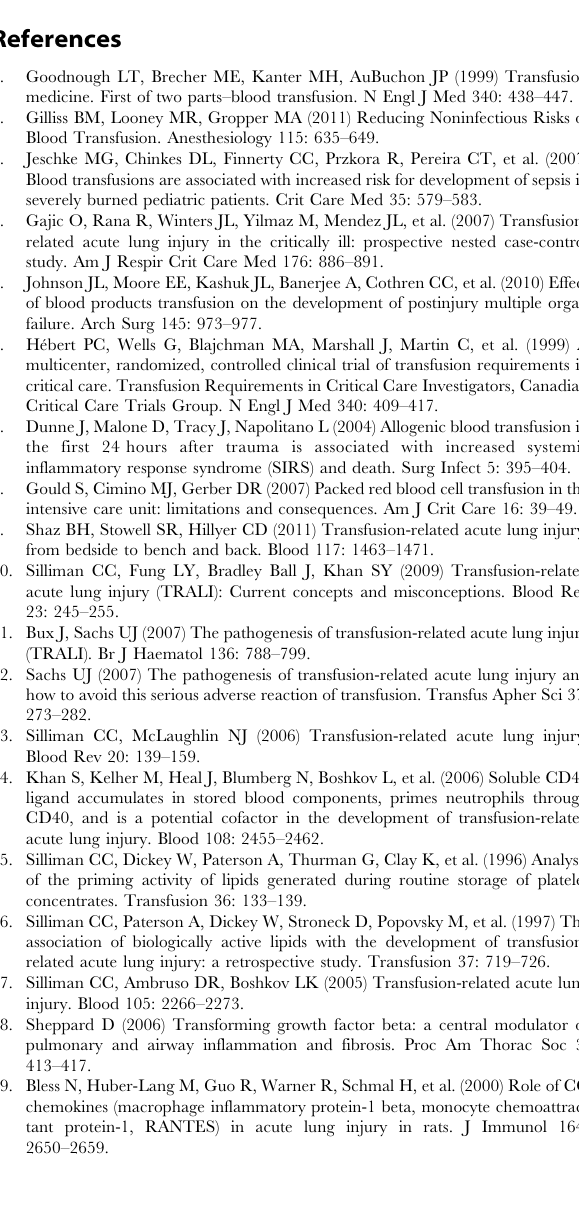
Table S9 Correlation of baseline sCD40L and lipid concentra- tion in blood products with transendothelial migration of